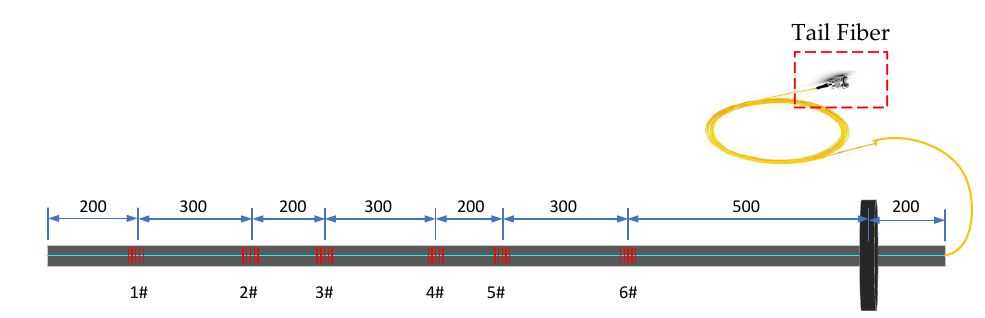
Figure 3. Structure diagram of the limit slot for the FBG dynamometry bolt.